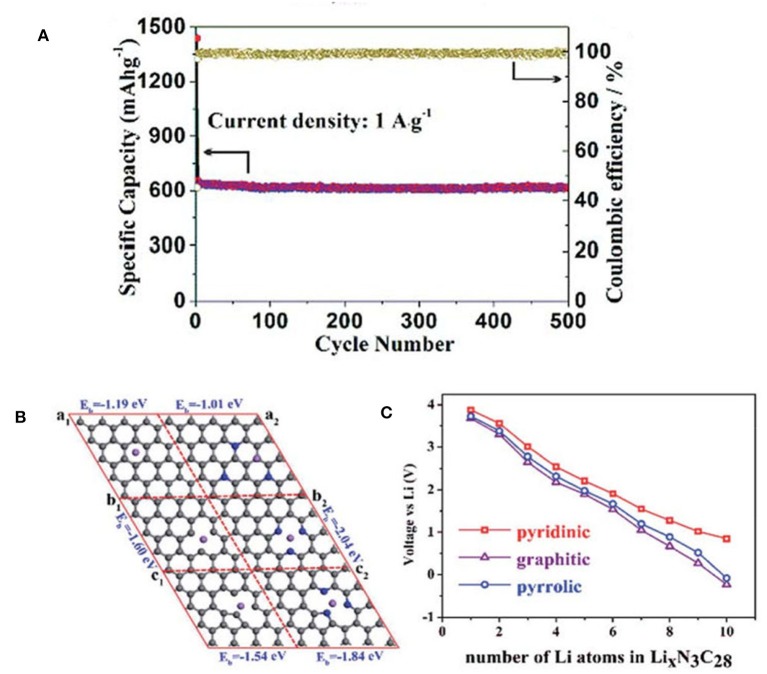
(A) Nitrogen-doped carbon honeycomb-like structure assembled by two-dimensional mesoporous nanosheets were successfully fabricated via a thermal annealing and acid etching strategy. The sample exhibited excellent electrochemical properties as anode materials for LIBs. (B) Comparison of three kinds of C stable sites before and after doped N after Li atom adsorbed (al-pure Graphene, a2-N doped Graphene, bl-pure pyridinic, b2-N doped pyridinic, cl-pure pyrrolic, c2-N doped pyrrolic). (C) Average potential of different numbers of Li intercalation in the graphitic, pyridinic, and pyrrolic defect structures of graphene. From Han et al. (2018) with permission from Royal Society Chemistry.